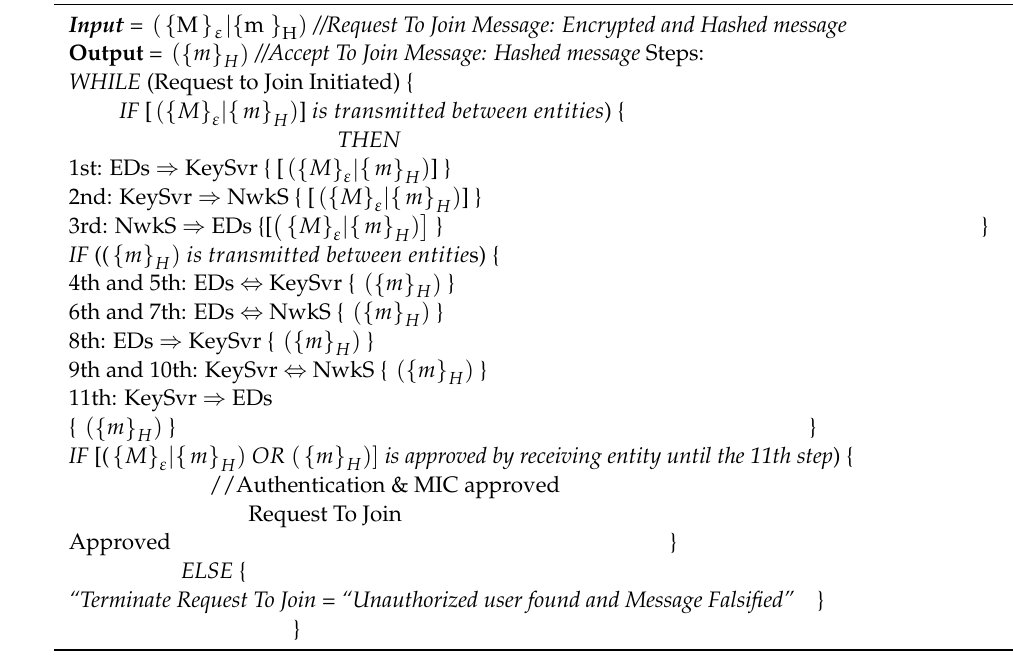
Algorithm 1: TKMS Algorithm